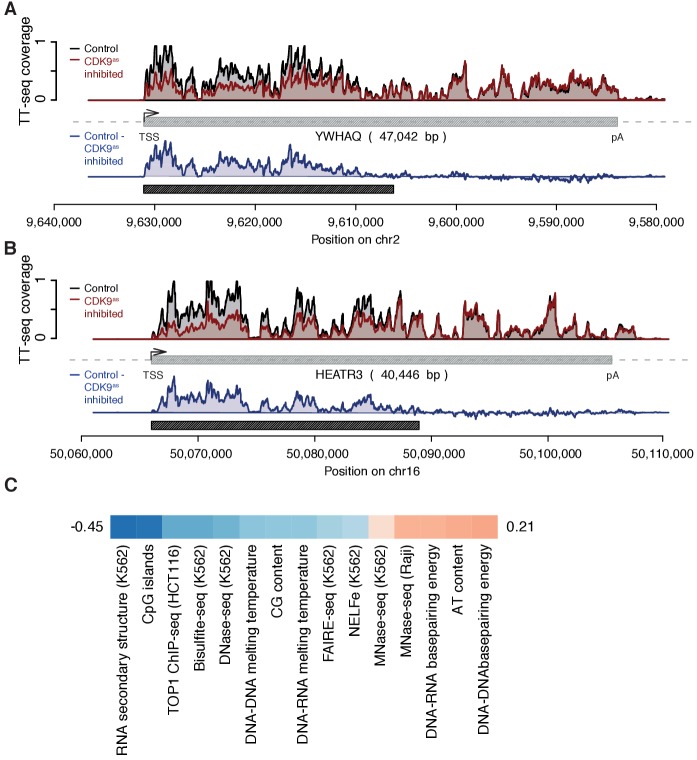
Example genome browser views of TT-seq signals in CDK9as cells with estimated response window and genomic features correlating with elongation velocity.(A) YWHAQ gene locus (47,042 [bp]) on chromosome 2. The upper panel shows TT-seq signal with CDK9as inhibitor (red) and control (black). Grey box depicts transcript body from transcription start site (TSS, black arrow) to polyA site (pA). Lower panel shows the difference of TT-seq signal (control – CDK9as inhibited in blue). Black rectangle depicts the estimated response window according to elongation velocity estimate (Materials and methods). (B) HEATR3 gene locus (40,446 [bp]) on chromosome 16 depicted as in (A). (C) Color encoded Spearman correlation coefficients (color encoded, −0.45 in blue to 0.21 in red) of elongation velocity [kbp/min] against genomic features and measures of transcriptional context (Materials and methods, Supplementary file 1).